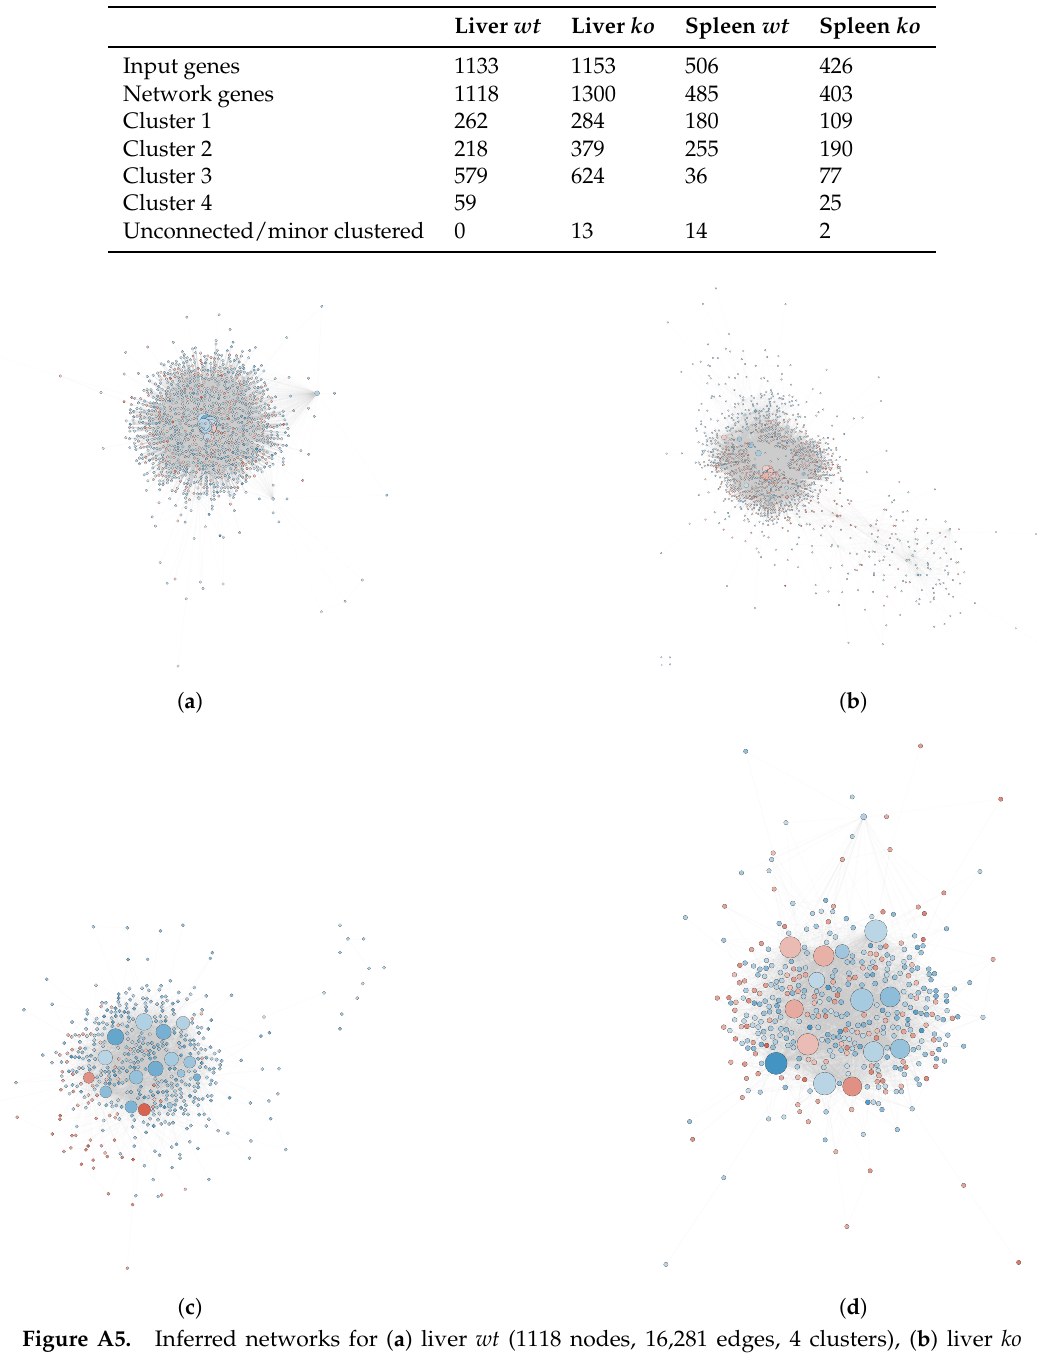
Table A1. Number of DEG used as input to EnGNet for network reconstruction and their latter distribution in inferred networks. Genes that were not assigned to a cluster (or were comprised in minoritary clusters) were not taken into consideration for enrichment analyses.